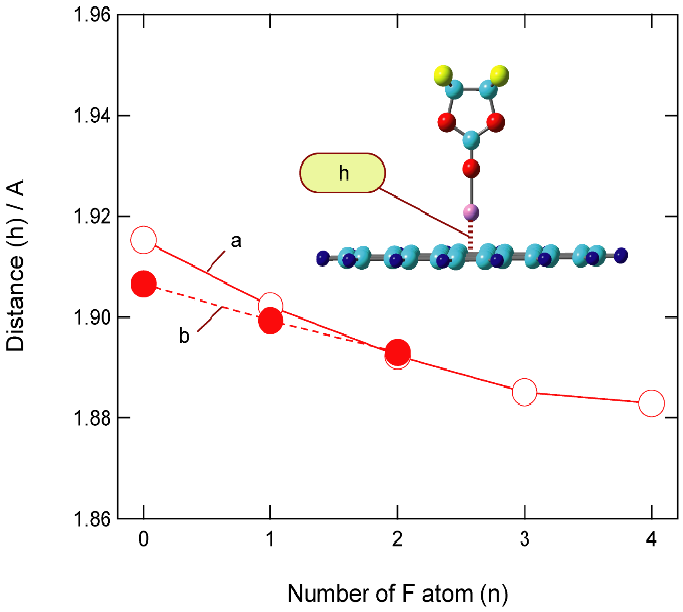
Figure 6. Distances of the lithium atom of Li + ‐ EC (or Li + ‐ VC) from the graphene surface ( h ) plotted as a function of n, the number of F ‐ atoms. The values were calculated at the B3LYP/6 ‐ 31G(d) level. ( a ) Li + ‐ EC; ( b ) Li + ‐ VC.